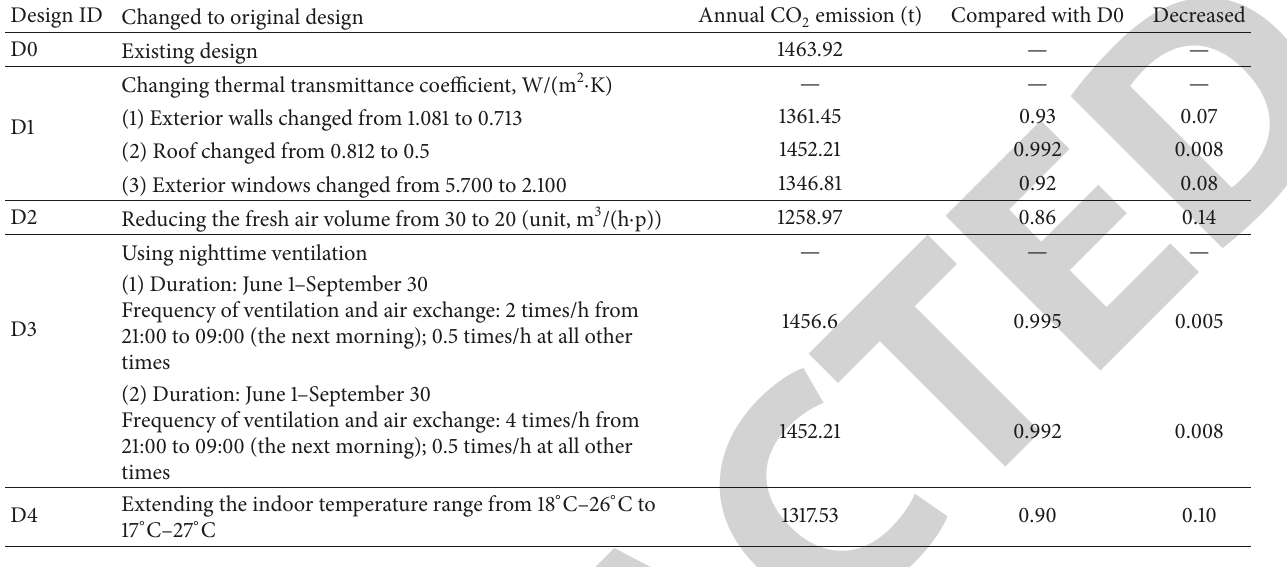
emissions by altering design configurations. 2